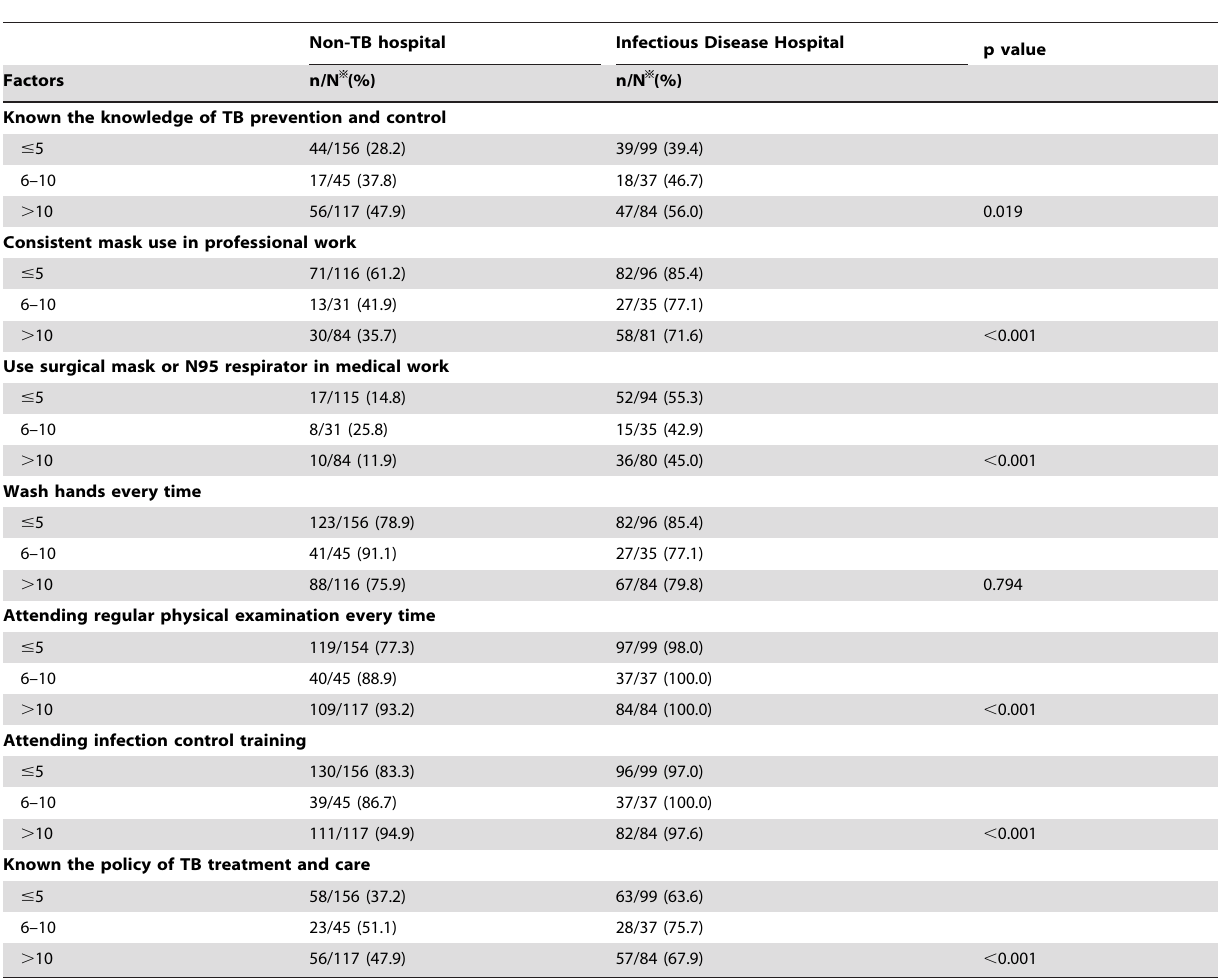
Table 4. Knowledge about TB and Practice of Airborne Infection Control with the LTBI, stratified by job-duration.